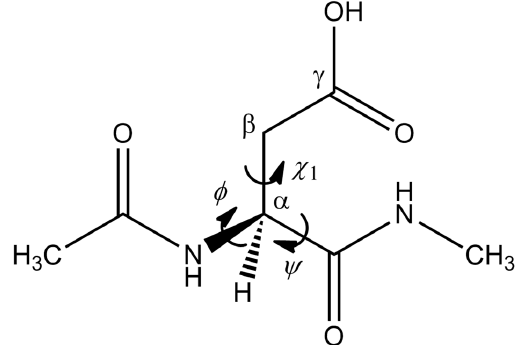
Figure 1. The model compound used in the present study (Ac– L -Asp–NHMe, Ac = acetyl, Asp = aspartyl, and NHMe = methylamino). The φ (C–N–C α –C) and ψ (N–C α –C–N) dihedral angles